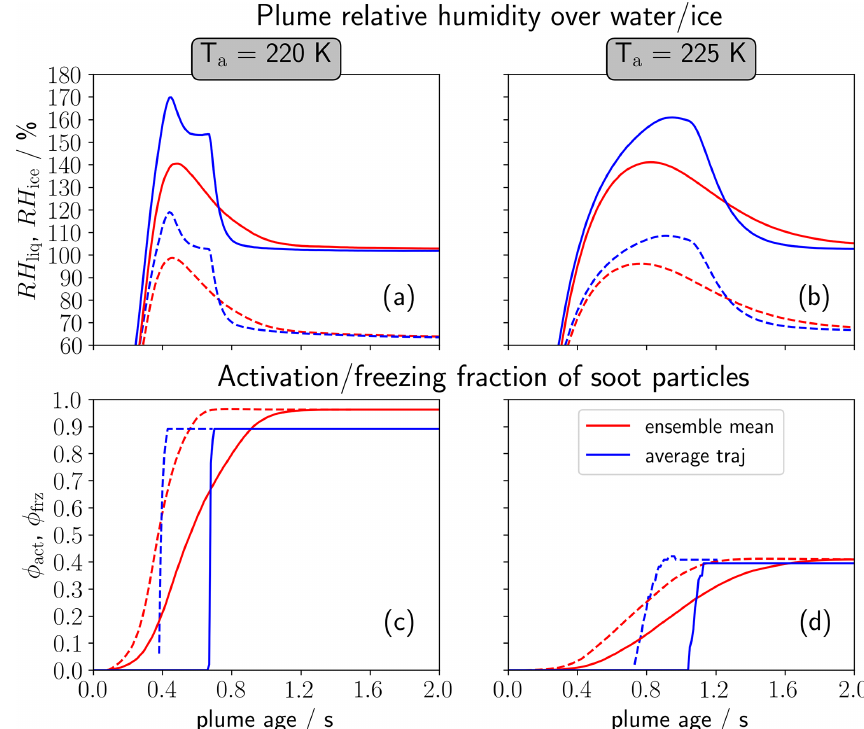
Figure 2. Temporal evolution of (a, b) plume relative humidity over water (dashed) and ice (solid) and of (c, d) the fraction of soot particles activating into water droplets (dashed) and forming ice crystals (solid). The left column (a, c) shows the baseline case with ambient temperature T a = 220K and the right column (b, d) the near-threshold case with T a = 225K. Results are shown for the ensemble mean (red) and the average traj (blue)